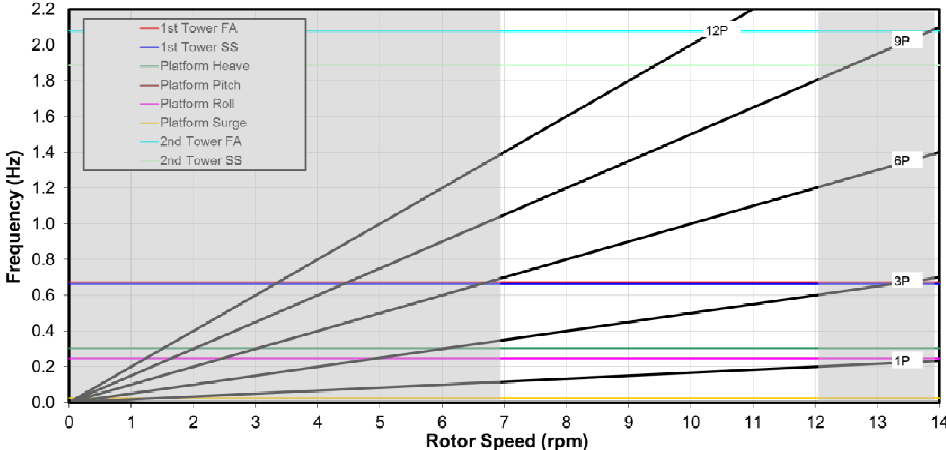
Figure 12. Campbell diagram of the WindStar